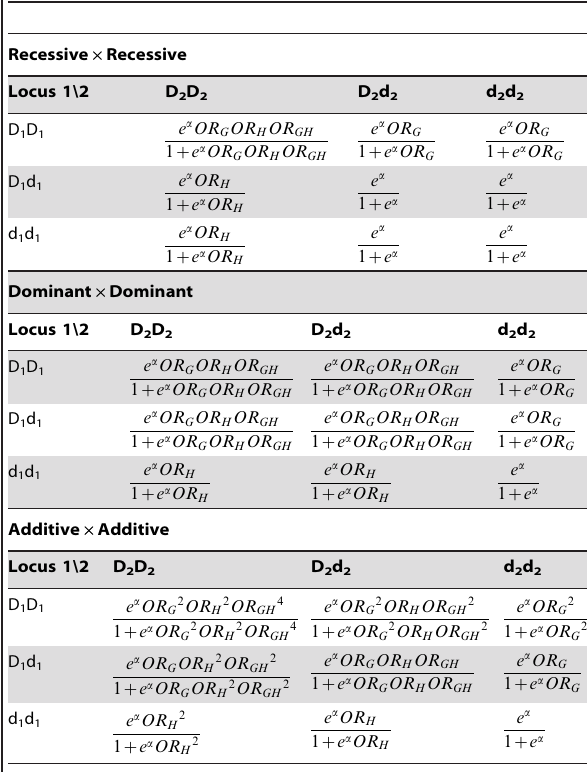
Table 3. Two-locus disease models.